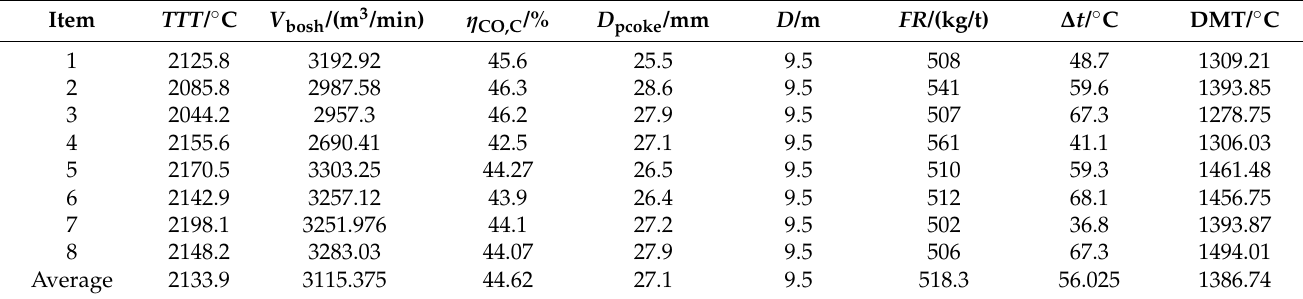
Table 4. Coke quality parameters and operation parameters of the 1280 m 3 BF in steelworks.